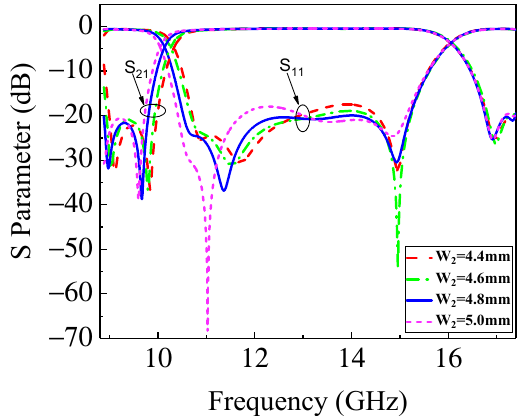
Figure 6. Simulation of S parameters when width W 2 of the U-shaped microstrip lines is varied from 4.4 mm to 5 mm, with a step of 0.2 mm increment.